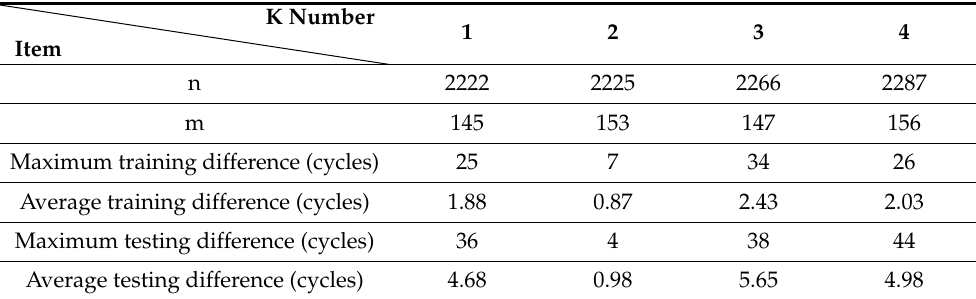
Table 14. The performance of the sub-models.